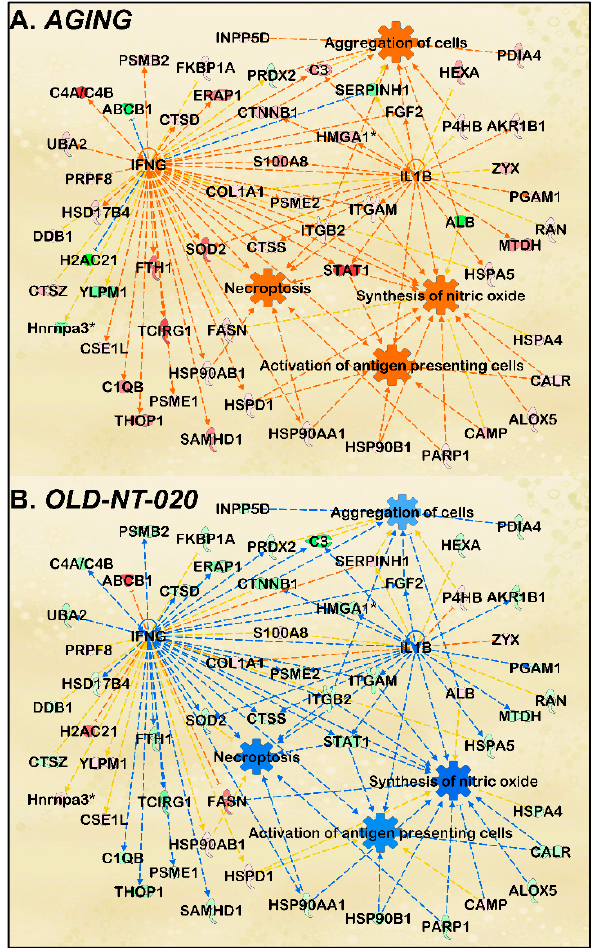
Figure 4. Microglial functions modified during aging and with polyphenol supplementation. IPA network analysis featuring annotated microglial functions enriched by MS-detected proteins